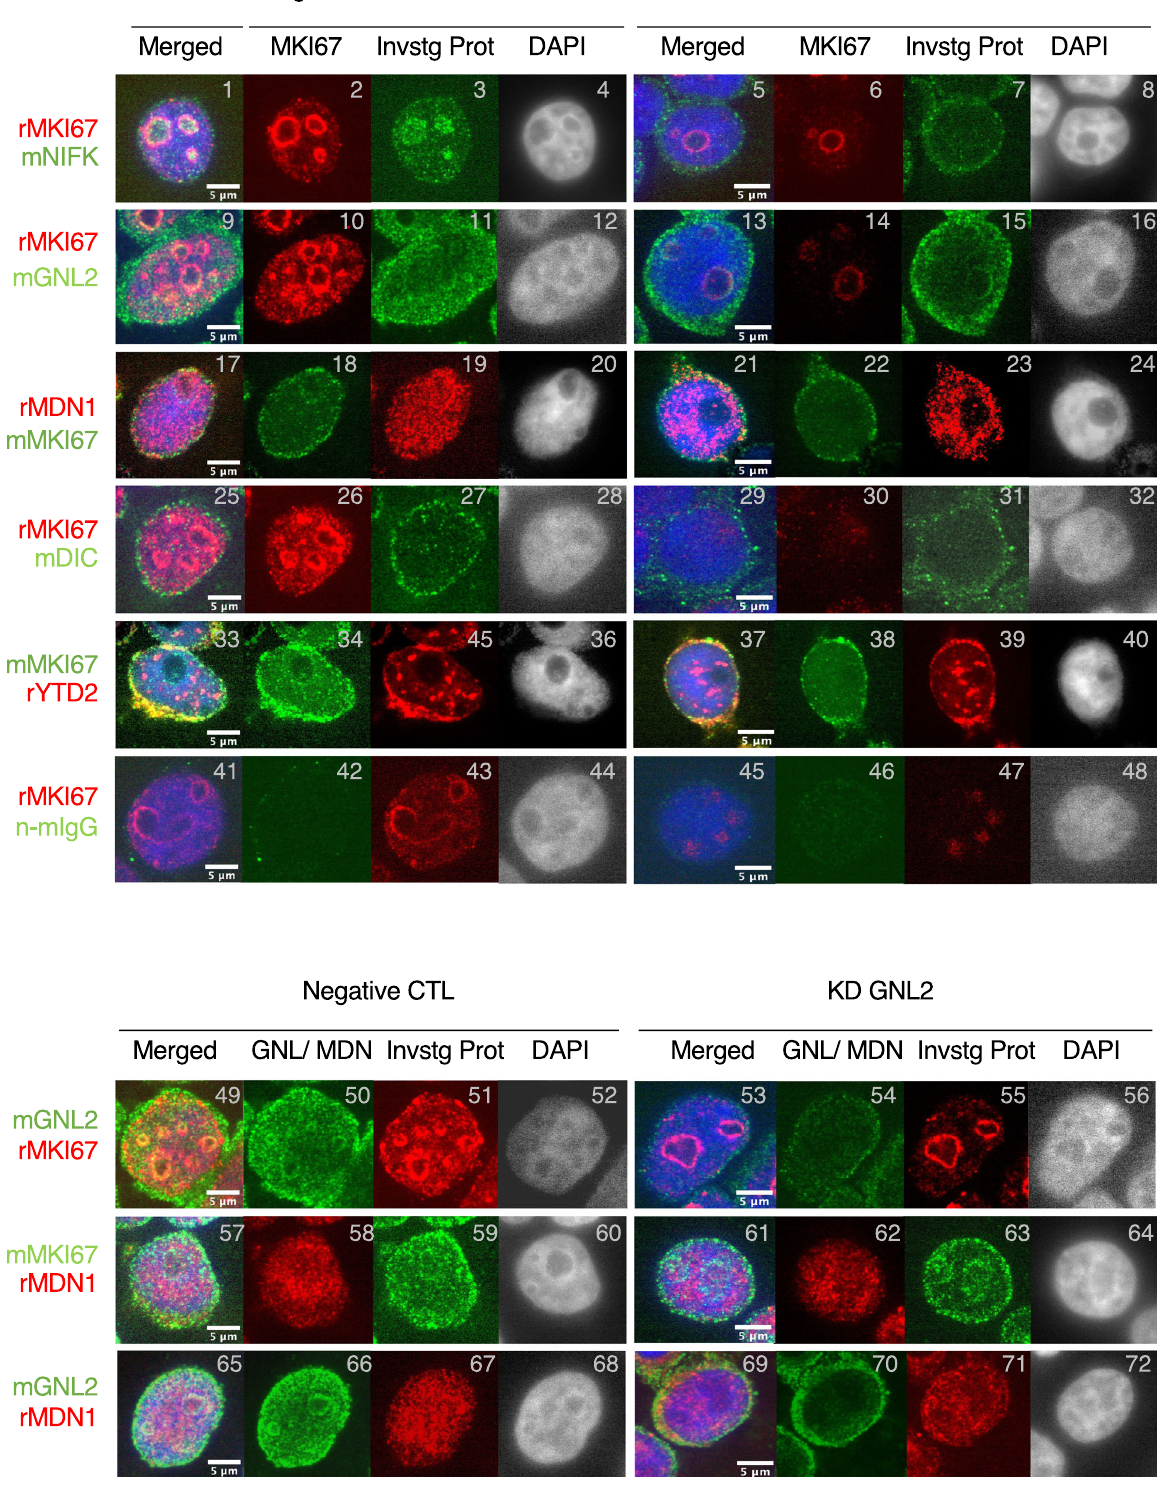
Fig. 4 Double immunostaining of HEK293T cultures. Gene knockdown was performed with 10 nM universal negative control siRNA (left,) and 10 nM siRNA for MKI67 and GNL2 (right). Red and green show proteins stained with rabbit antibodies and mouse antibodies, respectively. Rabbit and mouse antibodies used for probing are shown to the far left in red and green. Invstg Prot column shows immunostaining of primary target proteins for the